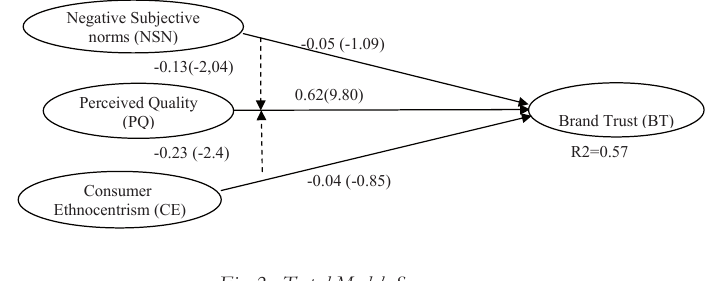
Fig. 2 - Tested Model. Source: